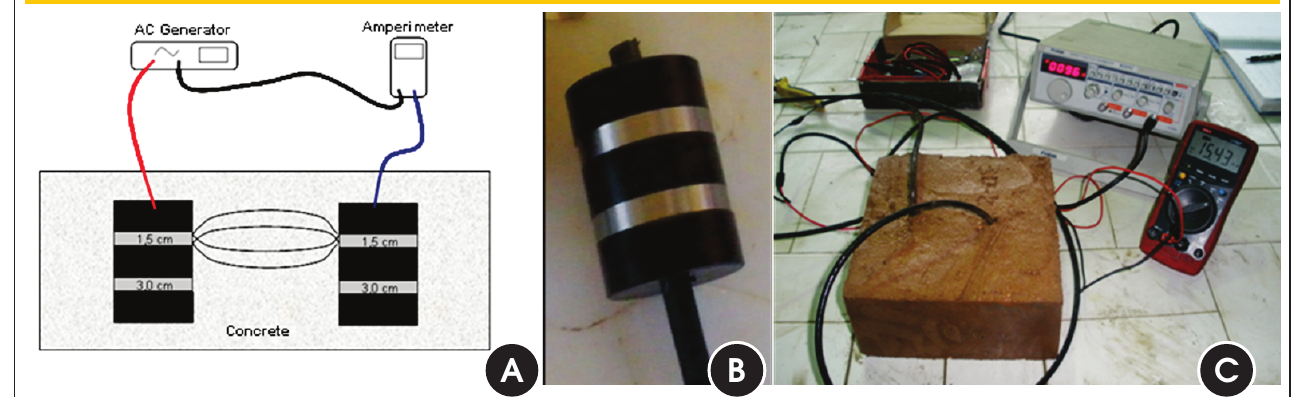
Figure 2 – (A) Schematic diagram of the measurement of concrete electrical